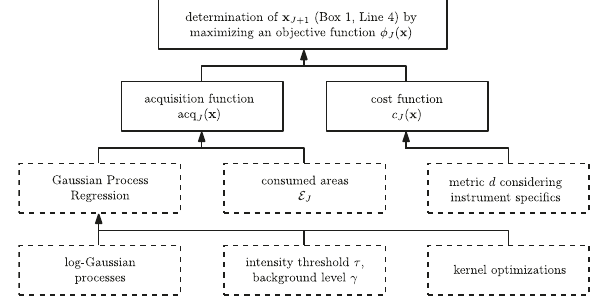
Fig.2|Schematicrepresentationofourapproachinthecontextofthegeneral experiment algorithm. The general components (solid line boxes) are composed of the speci fi c components (dashed line boxes) which mainly form our